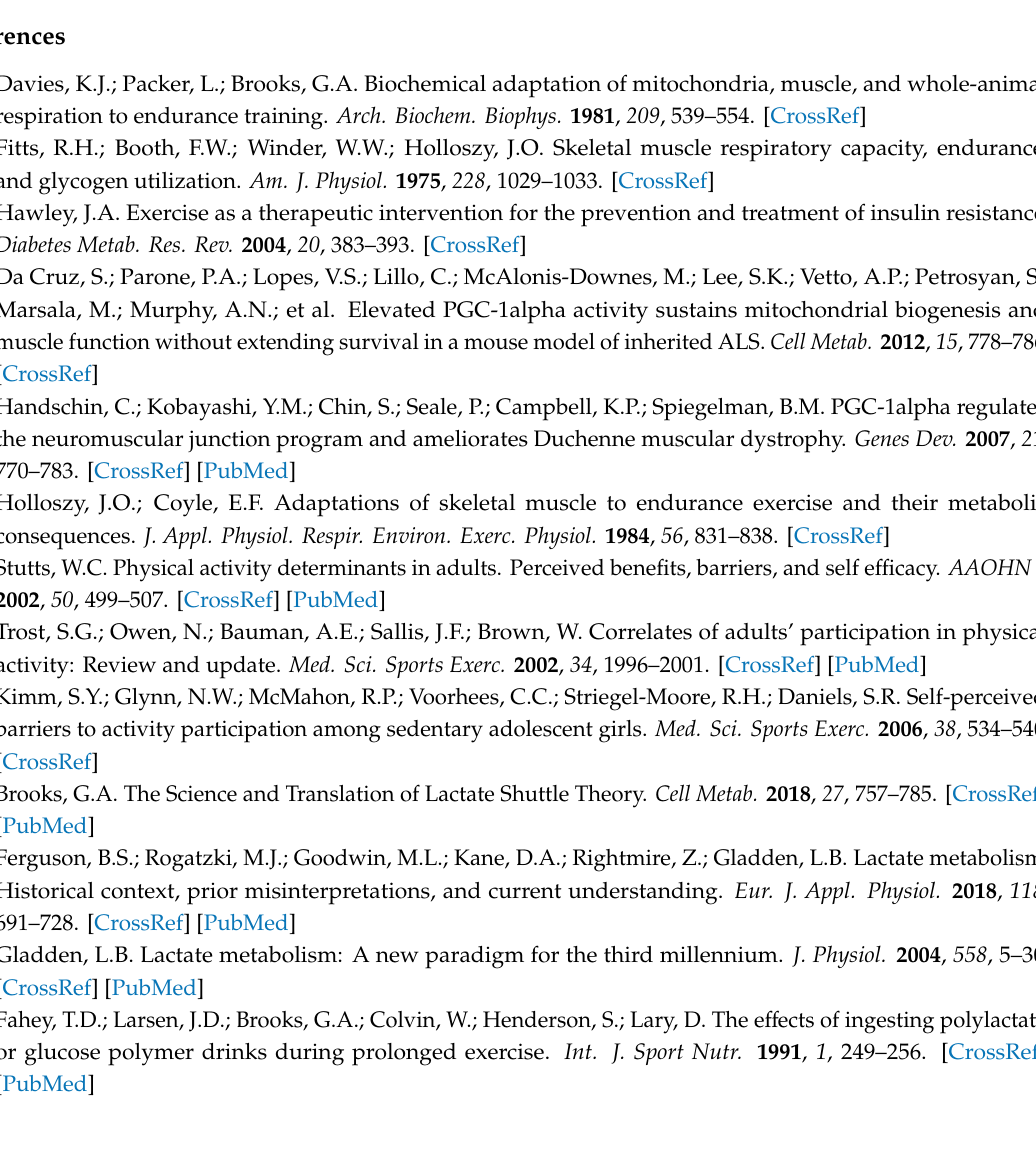
Table S1: Antibodies, Table S2: F values and degrees of